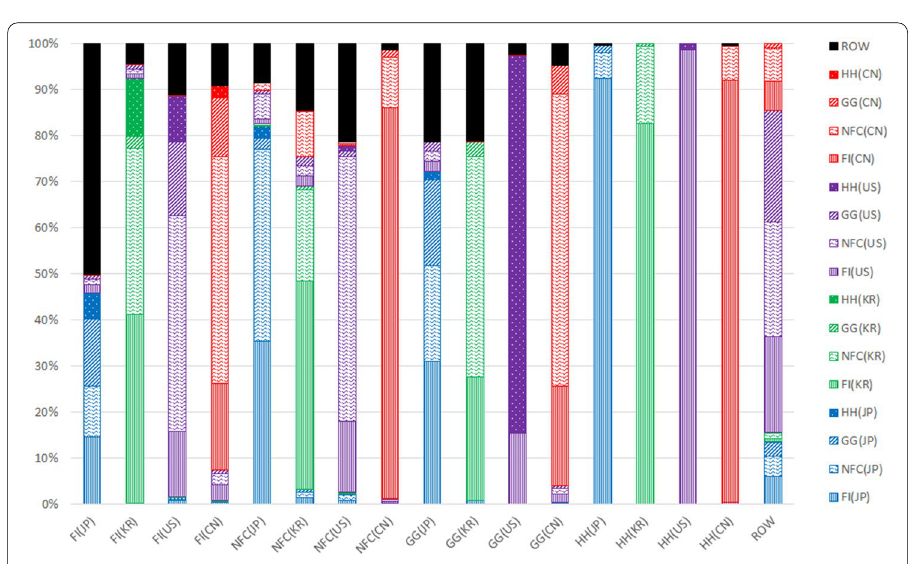
Fig. 4 Financial asset portfolio of four